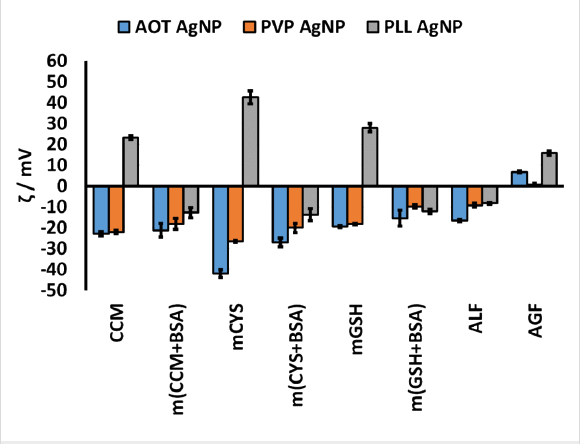
Figure 6: Changes in the ζ potential (in mV) of AOT-AgNPs, PVP- AgNPs, and PLL-AgNPs in different artificial biological media after 24 h of incubation. The media abbreviations are explained in Table